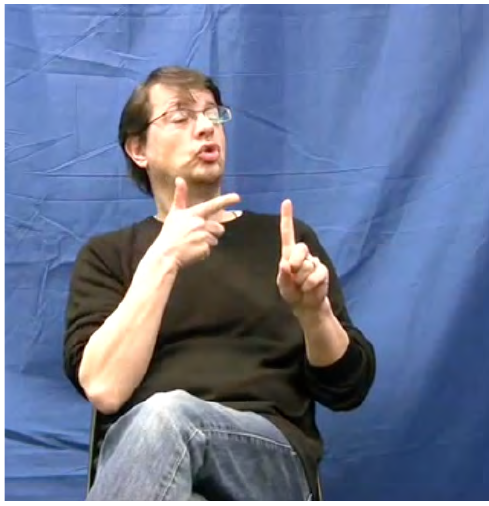
Figure 15. Example of ‘eyegaze only’ with modified indicating